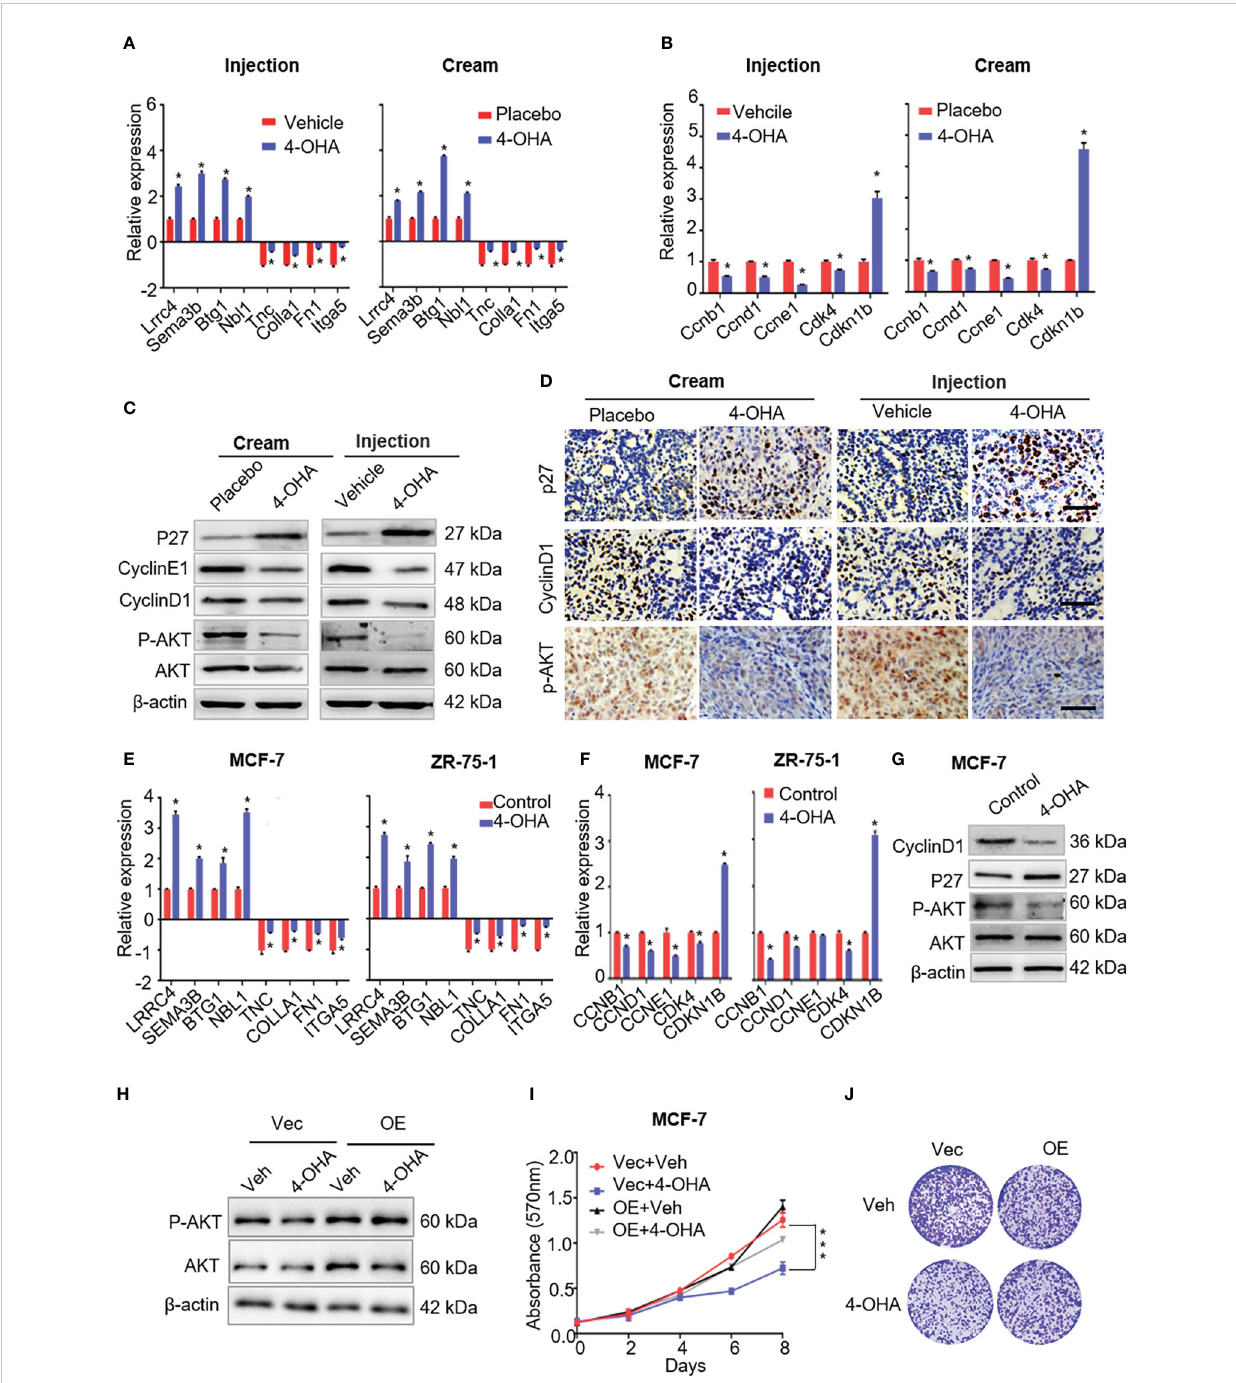
FIGURE 5 The effects of 4-OHA on extracellular matrix, cell cycle, and PI3K-Akt signaling pathways related genes or proteins. (A) The qRT-PCR was carried out to validate indicated DEGs in both 4-OHA cream and 4-OHA injection groups. (B) Representative levels of cell cycle-related genes by qRT-PCR. The key protein levels of the cell cycle and the PI3K-Akt signaling pathways were analyzed by western blotting (C) and immunohistochemistry (D) after 4-OHA treatment in DMBA-induced breast cancer tumors. Scale bar, 50 m m. (E – G) The expression levels of cell cycle, PI3K-Akt signaling pathways related genes, and tumor suppressors by qRT-PCR and western blotting in MCF-7 and ZR-75-A cells exposed to 1 m M of 4-OHA for 72 h. (H – J) Following Akt overexpression in MCF-7 cells, MTT (I) and Colony formation (J) assay were performed. The protein expression of Akt and P-AkT were analyzed by western blotting (H) . Vec, Vector; OE, overexpression; Veh, Vehicle. Data are represented as the mean ± SEM of three independent experiments, each in triplicate; bars, SEM. ***p ≤ 0.001, *p ≤ 0.05 vs.